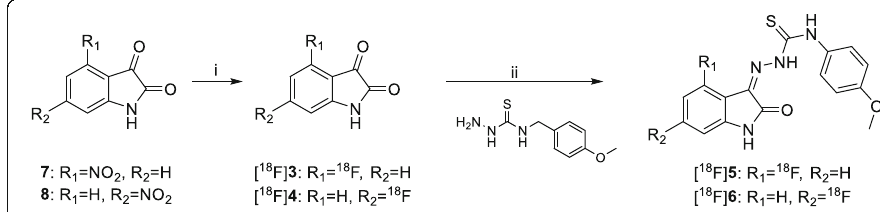
Fig. 2 reaction conditions: (i) DMSO, [ 18 F]fluoride, Kryptofix[2.2.2], K 2 CO 3 , 40 min. 140 °C (5 – 6% yield) (ii) ethanol, acetic acid, 30 min. 120 °C (35 – 50%